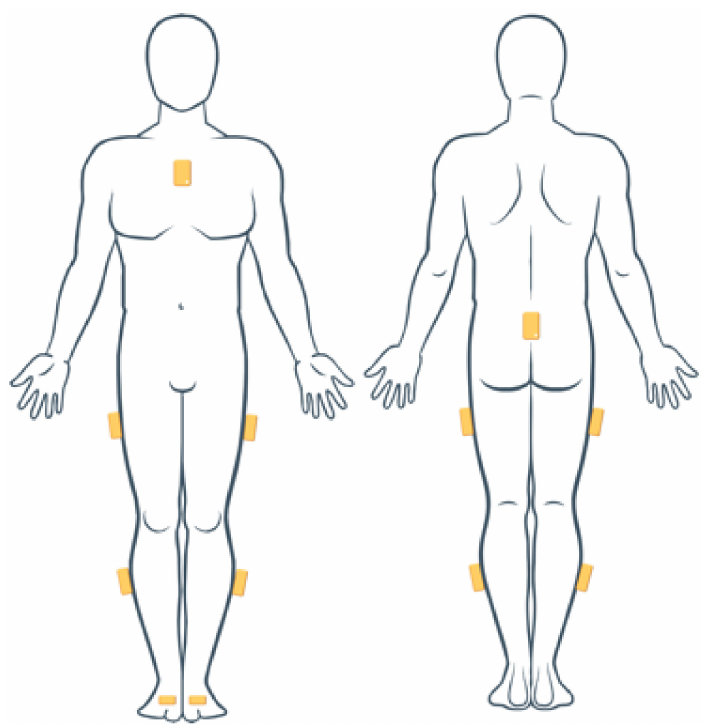
Figure 1. Inertial measurement units (IMUs) positions on the human body